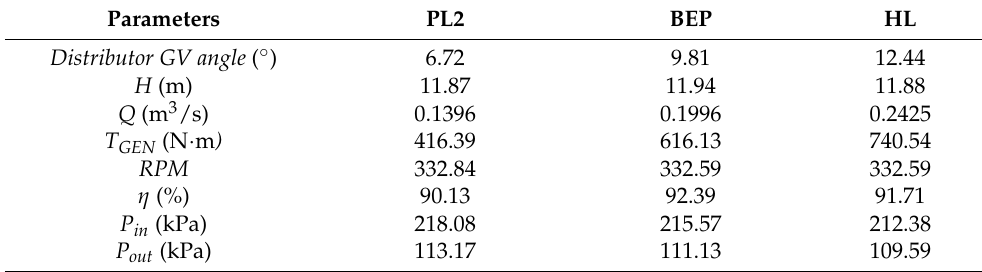
Table A1. Mean operational parameters of the NVKS Francis model turbine [43].